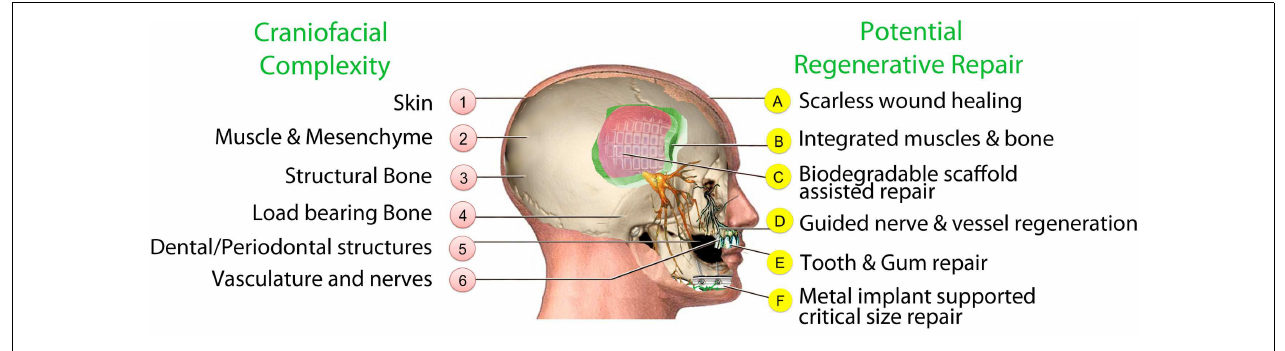
FIGURE 1 | Craniofacial structures and potential for regenerative